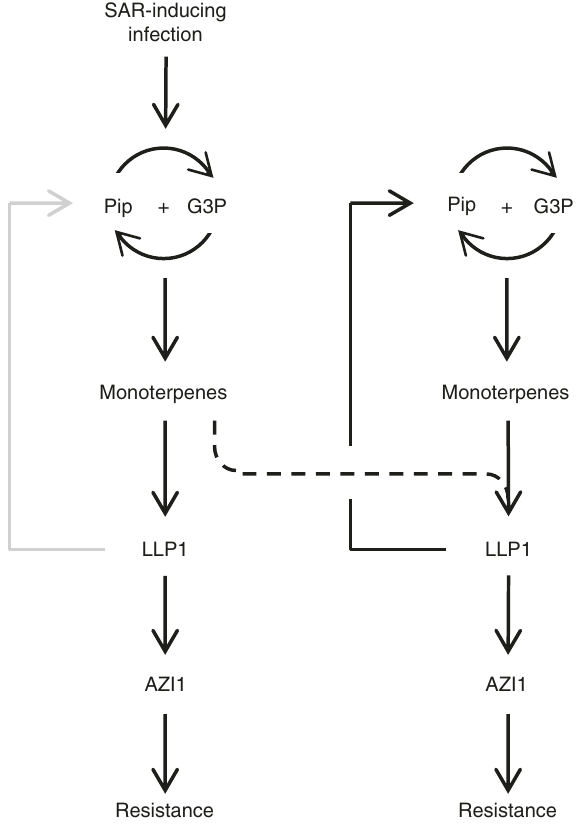
Fig. 9 Working model of systemic and plant-to-plant propagation of innate immunity. A Systemic acquired resistance (SAR)-inducing infection triggers pipecolic acid (Pip) and glycerol-3-phosphate (G3P) accumulation, which stimulate each other in a positive feedback loop acting upstream of monoterpene emissions. Monoterpenes subsequently enhance salicylic acid (SA)-associated immunity through the SAR signaling intermediates LEGUME LECTIN-LIKE PROTEIN1 (LLP1) and AZELAIC ACID INDUCED1 (AZI1). At the same time, monoterpenes are emitted and act as cues that are perceived by systemic leaves and also neighboring plants. At the site of monoterpene perception, SA-associated immunity is enhanced through LLP1 and AZI1. In addition, LLP1 drives a positive feedback loop with Pip and G3P to stimulate monoterpene biosynthesis and emission, potentially promoting the generation of a wave of plant-derived volatile defense cues moving between leaves in a canopy or rosette and between neighboring plants in a